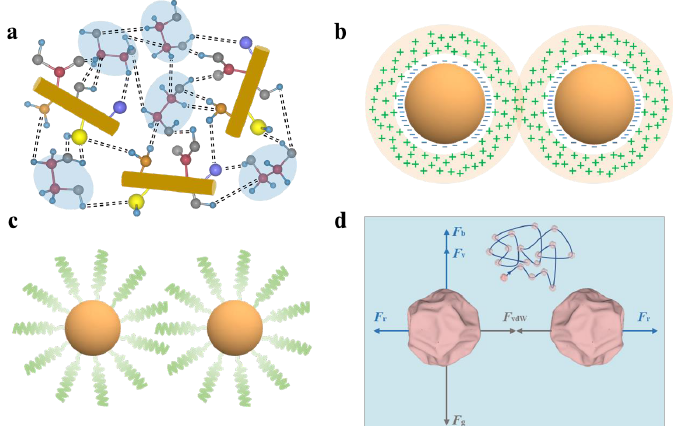
Figure 3. Schematics showing different types of stabilization strategies for preparing medium-tem- perature solar-thermal nanofluids: ( a ) hydrogen bonding stabilization, ( b ) electrostatic stabilization, ( c ) steric stabilization, ( d ) self-dispersion